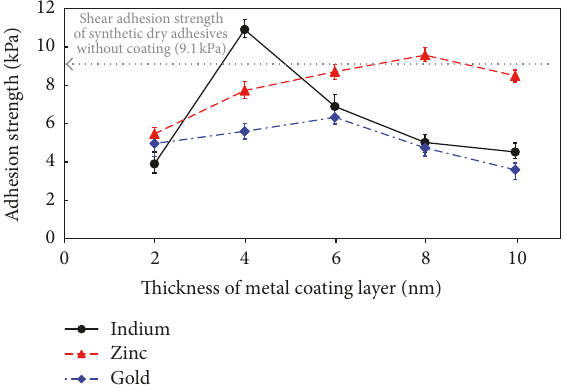
Figure 3: Shear adhesion strength of synthetic dry adhesives with respect to coating materials and thickness (the gray dotted line indicates the shear adhesion strength of synthetic dry adhesives without a metal